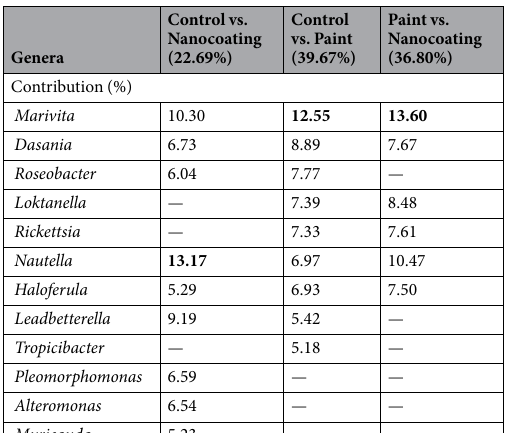
— Table 1. SIMPER analysis for estimation of bacterial genera contribution to total dissimilarity. The contribution of particular genus of bacteria towards the total dissimilarity (%) between the bacterial communities using SIMPER analysis.